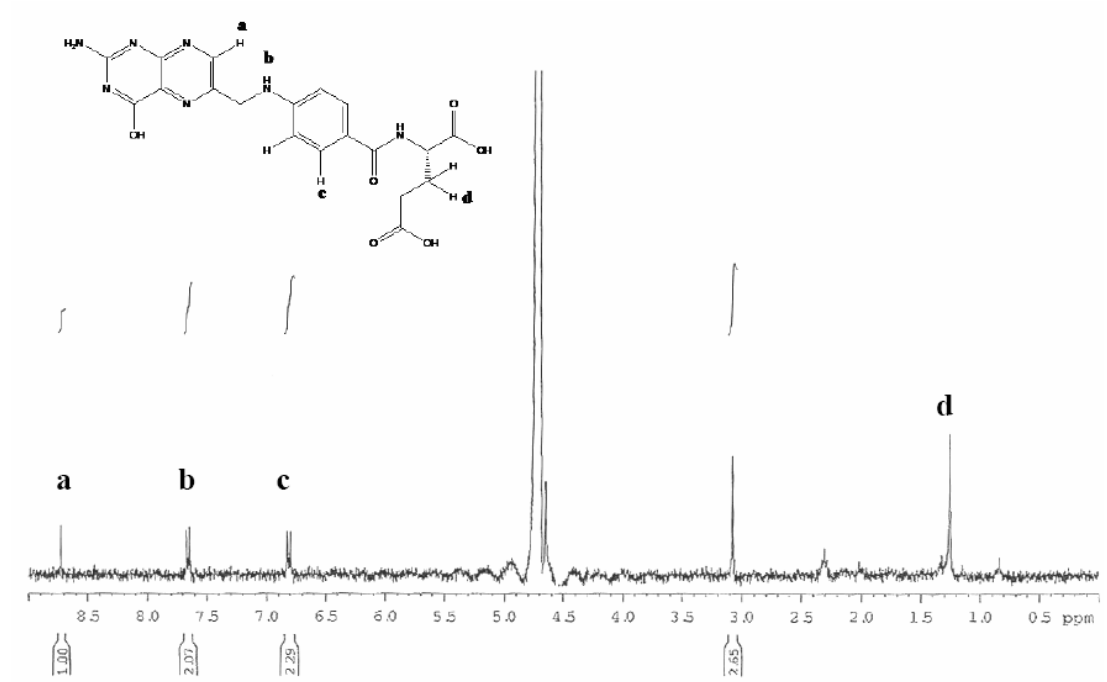
Figure 3. NMR spectrum of the surface-modified GNPs with folic acid; the structure of folic acid is shown in the left